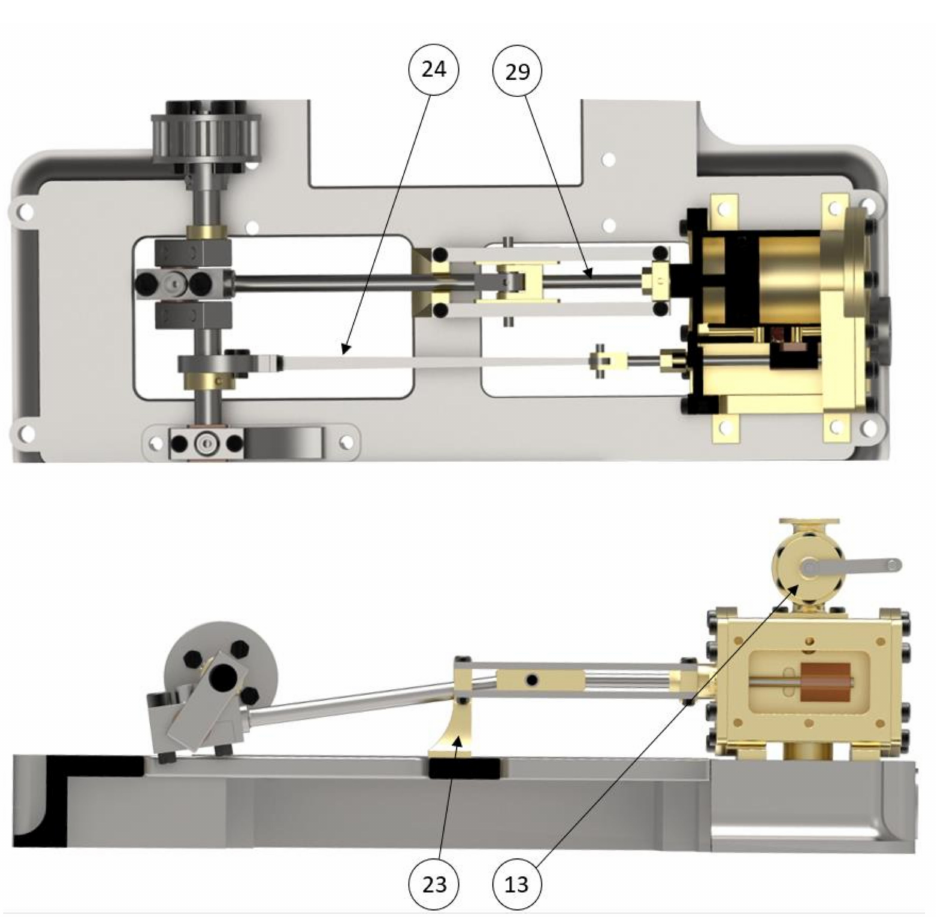
Figure 6. Top and front views of the piston-rod mechanism and functioning of the